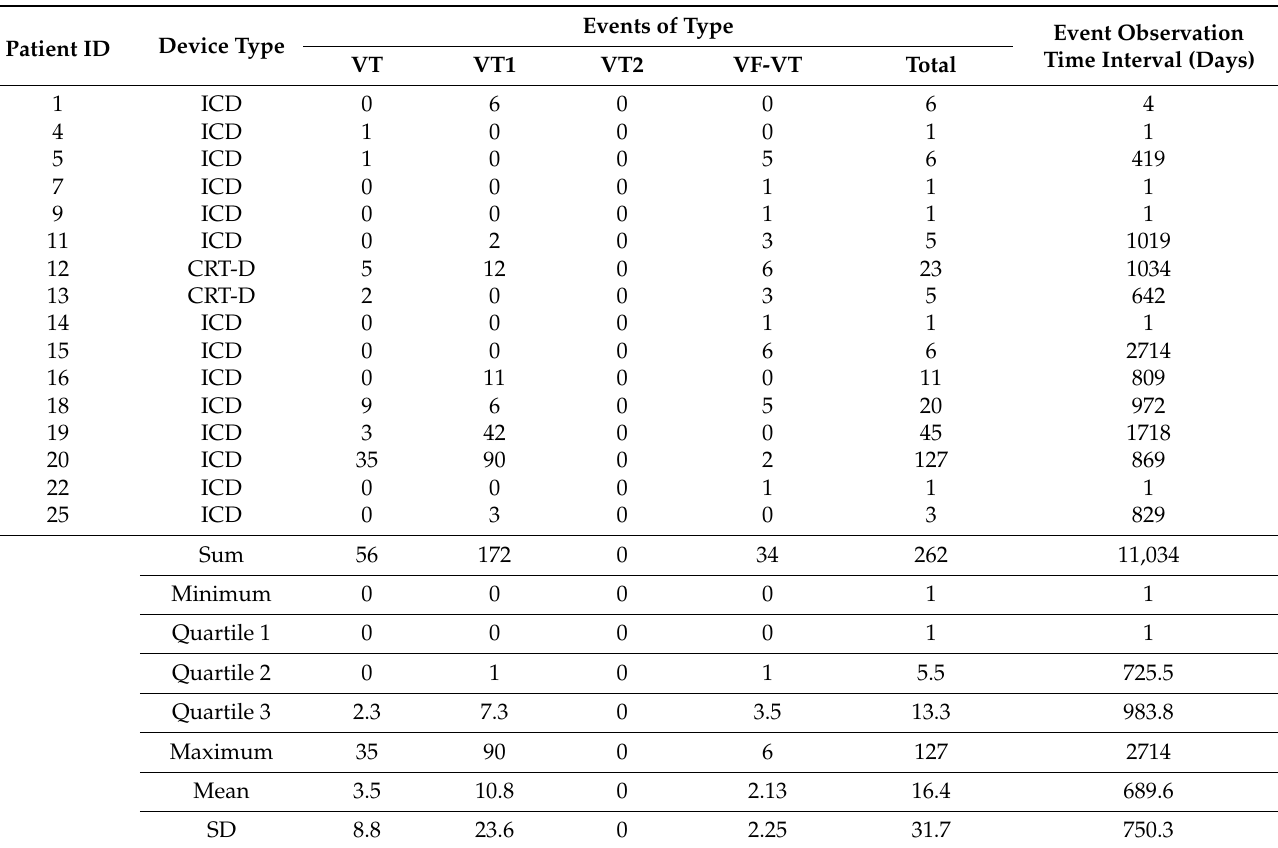
Table A1. VA events by type and monitoring days (16 patients). The remaining 11 patients (up to 27) did not have VA events of the types included in this analysis.